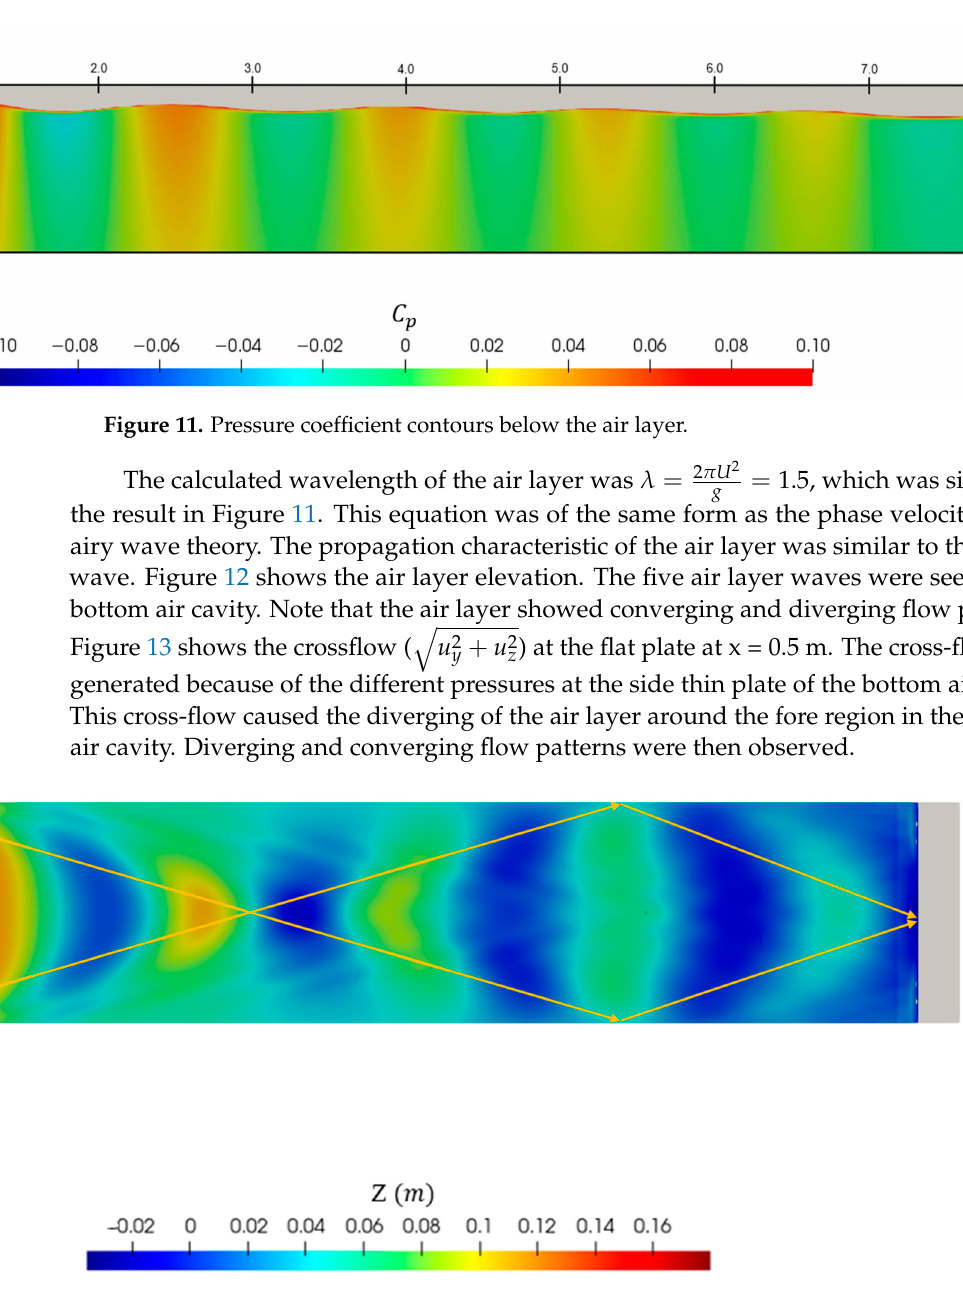
Figure 13. Cross flow at x = 0.7 m ( 𝐹 (cid:3045) = 0.173, 𝐶 (cid:3044) = 0.149 ). The drag reduction of the flat plate was predicted using the CLSVOF and VOF solv- ers. Figure 14 shows the total drag reduction rate ( 𝜂 (cid:3021) ) for various injected airflow rates